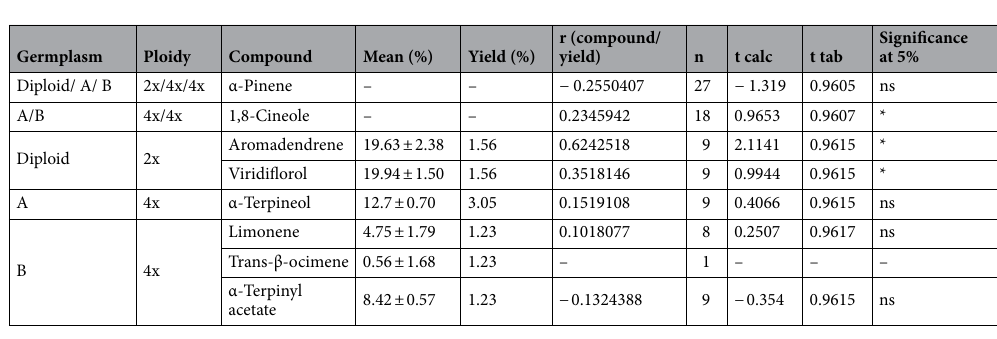
Table 2. Chemical identification of the compounds present in diploid and autotetraploid E. benthamii germplasms.